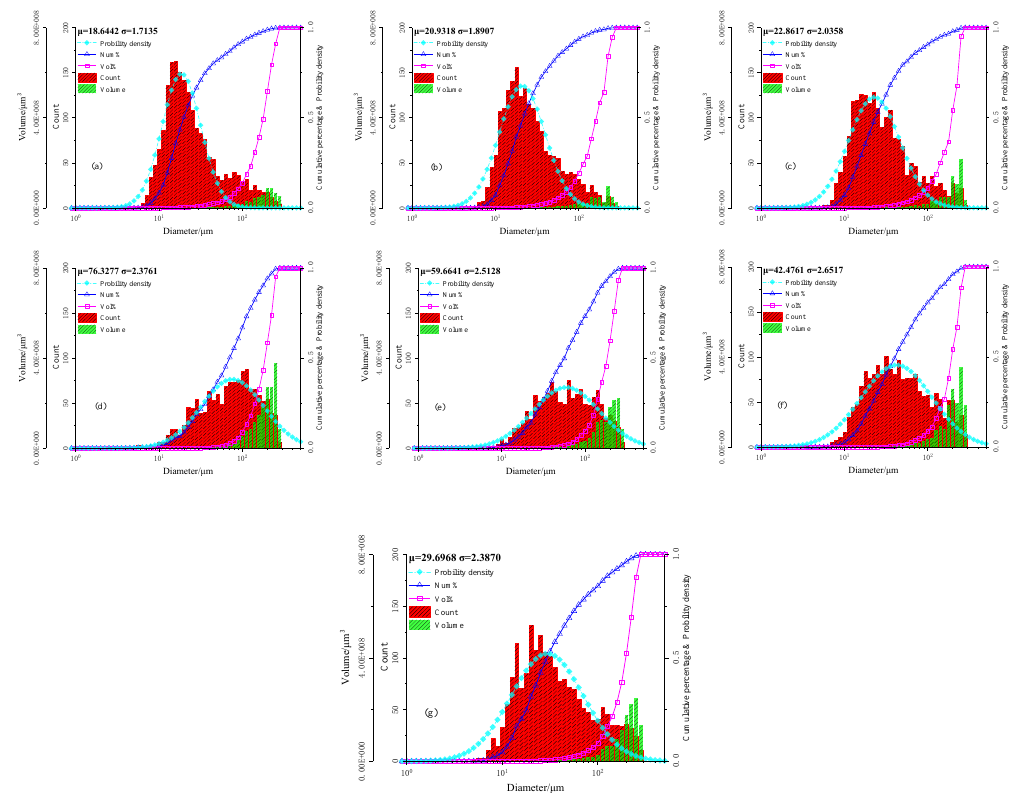
Figure 12. Statistical characteristics of droplet size at different measuring points along the z direction for the We g = 9.51, We j = 154.11, ( a ) z = 0, ( b ) z = 7.5, ( c ) z = 15, ( d ) z = 22.5, ( e ) z = 30, ( f ) z = 37.5, ( g ) z = 45.